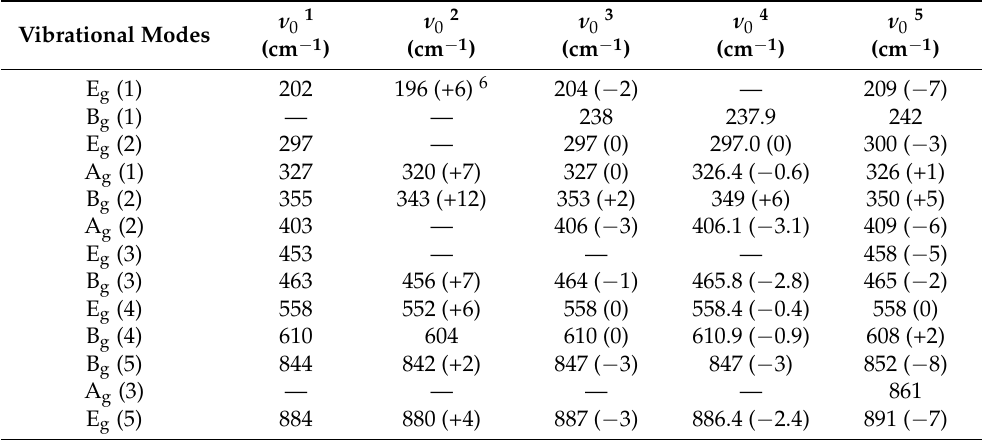
Table 2. Raman shifts of reidite.